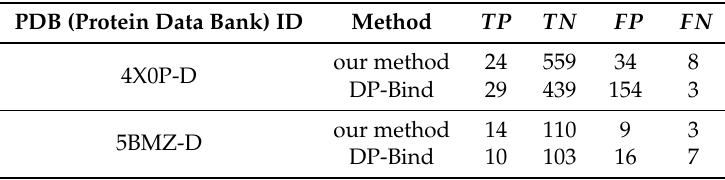
Table 8. Comparison with DP (DNA Protein)-Bind on 4X0P-D and 5BMZ-D.